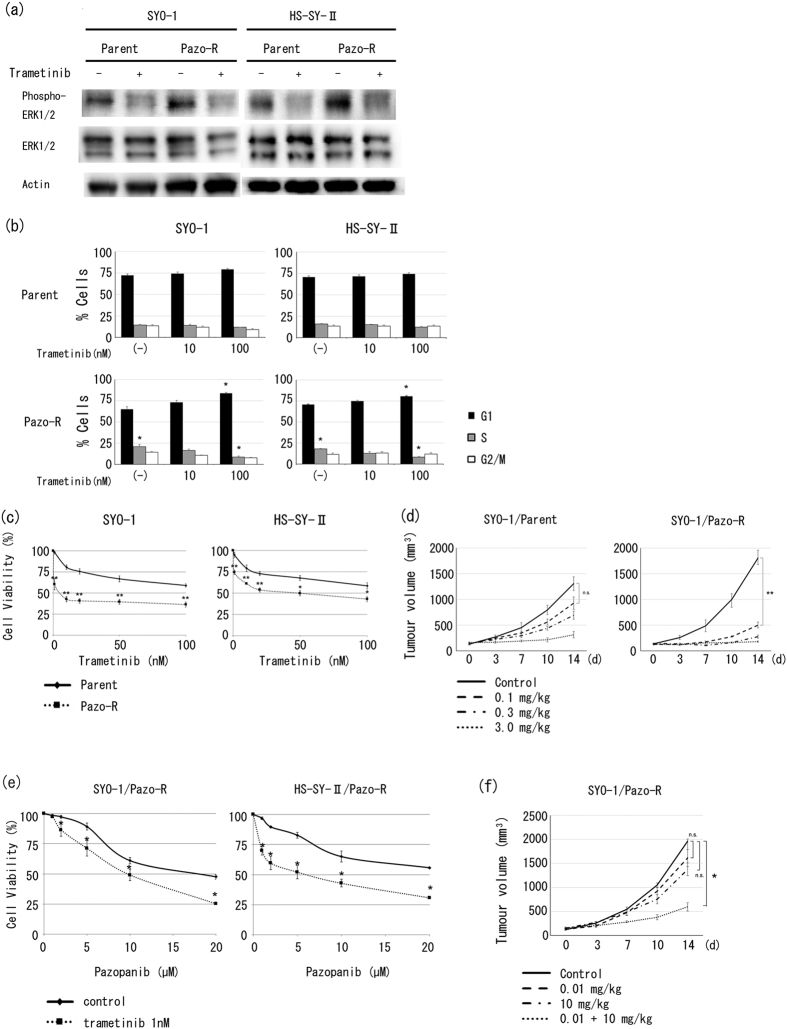
Trametinib, a MEK1/2 inhibitor, strongly inhibited growth and partially reversed pazopanib resistance of pazopanib-resistant clones.(a) Trametinib-induced inhibition of phosphorylation of ERK1/2 in SS clones was assessed by Western blot analysis with anti-ERK1/2 and anti-phospho-ERK1/2 antibodies. SS clones were pre-treated using 10 nM trametinib for 2 hours. (b) Cells were incubated with trametinib (10 nM and 100 nM) for 24 hours and fixed in 70% ethanol. After staining with PI, the DNA content of each fraction (e.g., G1, S, or G2/M) was analysed by flow cytometry. Values represent mean ± S.D. *P < 0.05; **P < 0.01, vs parental clones. (c) SS clones were incubated with various doses of trametinib for 48 hours. Viable cells were counted using a Z1 Coulter particle counter. Values represent mean ± S.D. *P < 0.05; **P < 0.01, vs parental clones. (d) Trametinib sensitivity of SYO-1 parental and pazopanib-resistant clones in vivo. **P < 0.01; n.s. not significant, vs trametinib-free condition. (e) Pazopanib-resistant SS clones were incubated with various doses of pazopanib and/or 1 nM trametinib for 48 hours. Viable cells were counted using a Z1 Coulter particle counter. Values represent mean ± S.D. *P < 0.05, vs trametinib-free condition. (f) Anti-tumour effect of 10 mg/kg pazopanib and/or 0.01 mg/kg trametinib in SYO-1 pazopanib-resistant clones in vivo. Values represent mean ± S.D. *P < 0.05, vs drug-free condition. Pazo-R represents pazopanib-resistant clone.